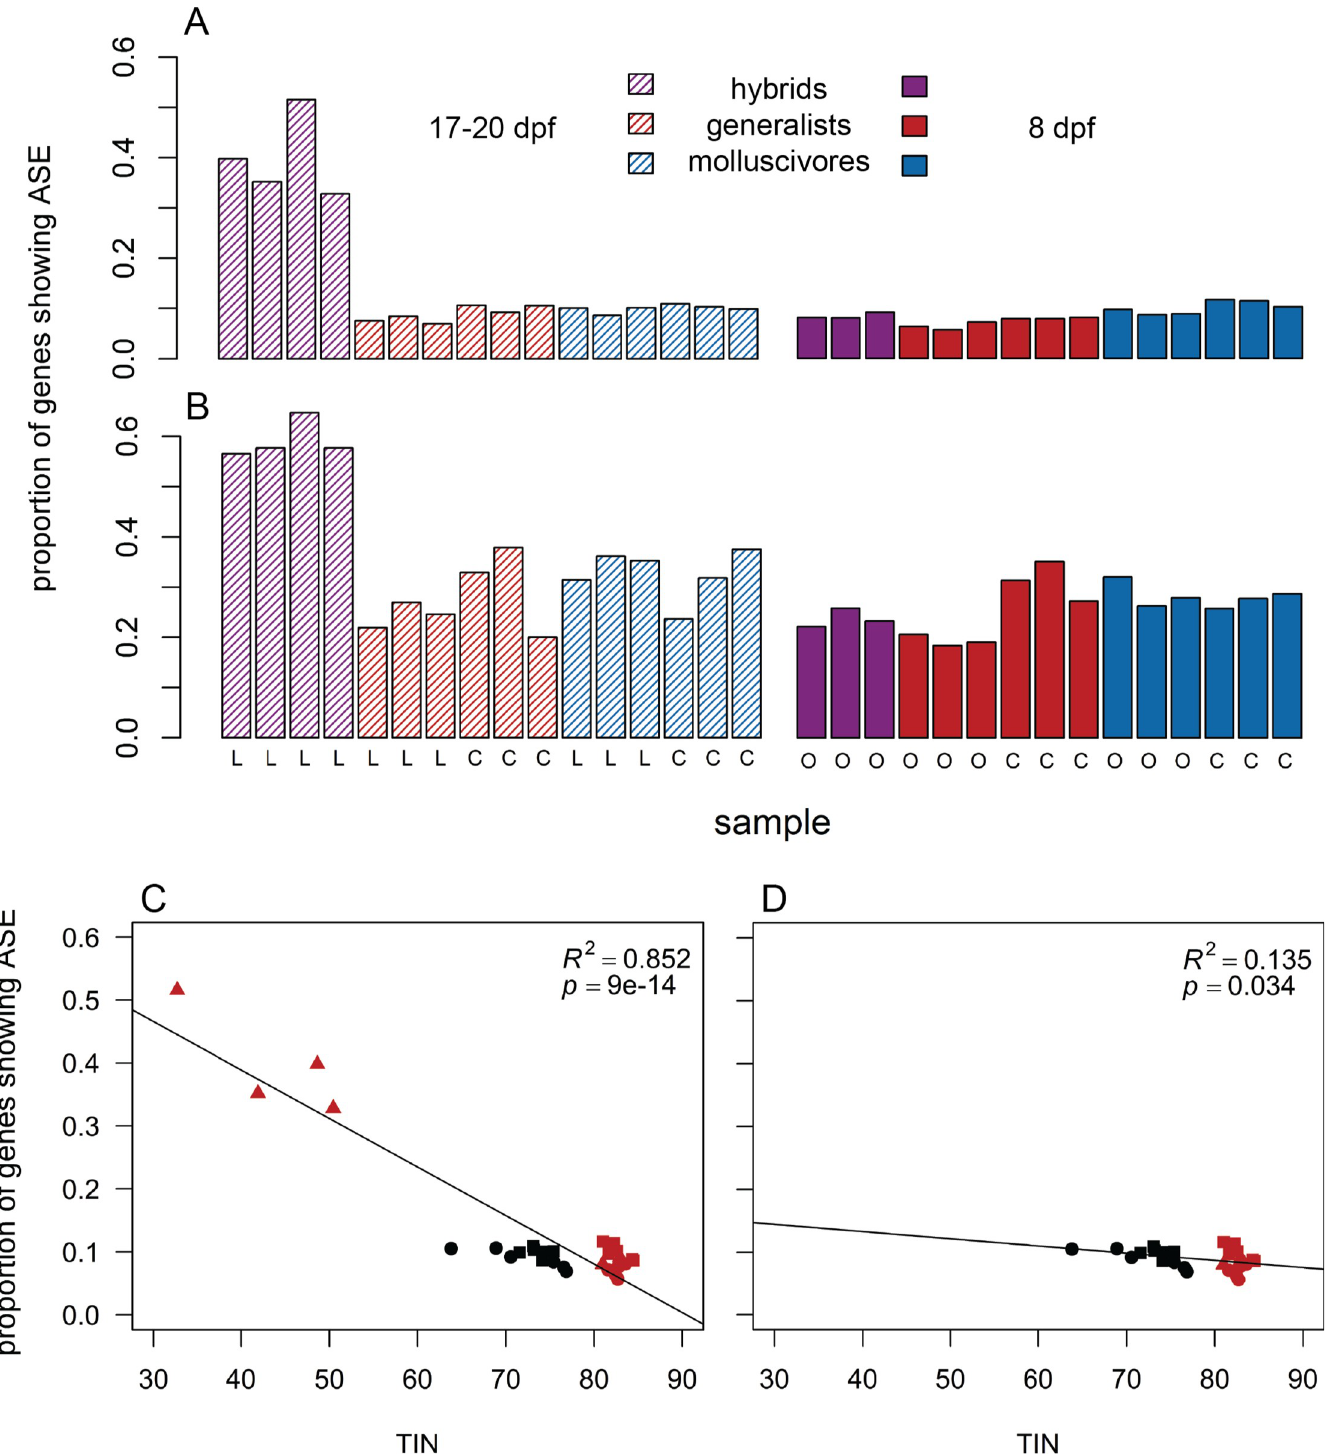
Fig 6. Hybrid craniofacial tissues show high levels of allele specific expression. F1 hybrid craniofacial tissues sampled 17–20 days post fertilization (dpf; striped purple bars) showed a higher proportion of genes showing significant allele specific expression compared to all other samples using a coverage threshold of (A) � 10 × reads supporting each heterozygous allele (ANOVA, P = 2.81 × 10 − 5 ) and (B) � 100 × reads supporting each allele (ANOVA, P = 3.85 × 10 − 4 ). 8 dpf = solid, 17–20 dpf = striped; hybrids = purple, generalists = red, molluscivores = blue; L = Little Lake, C = Crescent Pond, O = Osprey Lake. (C) TIN was significantly negatively correlated with ASE (linear regression; P = 9.04 × 10 − 14 ). (D) This correlation persisted when 17–20 dpf hybrid craniofacial samples were excluded from the linear